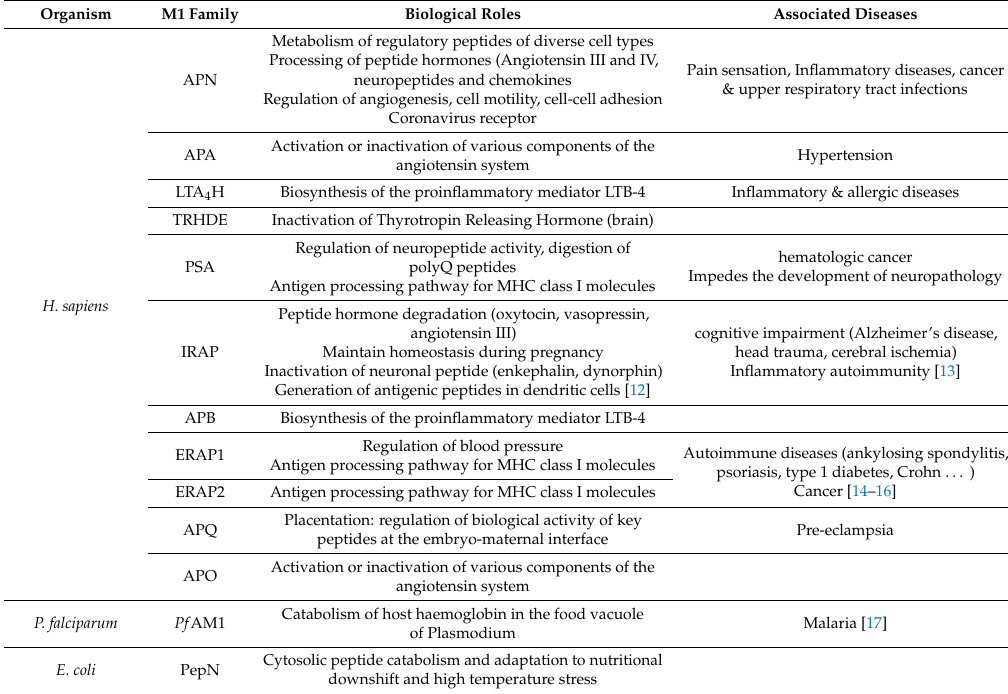
Current established biological functions for representative members of the M1 aminopeptidases